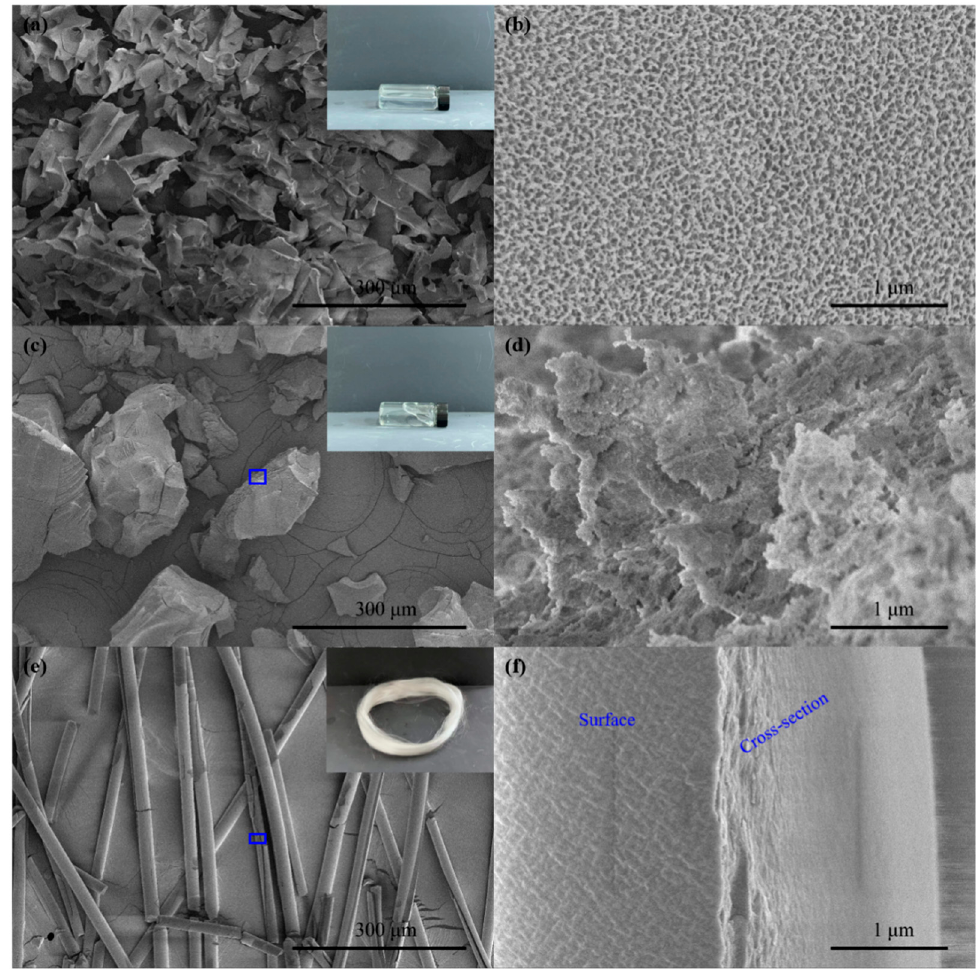
Figure 3. Morphologies of aluminum sols and gels with different solid contents: ( a , b ) 10.0 wt%; ( c , d ) 26.4 wt%; ( e , f ) 31.2 wt%.